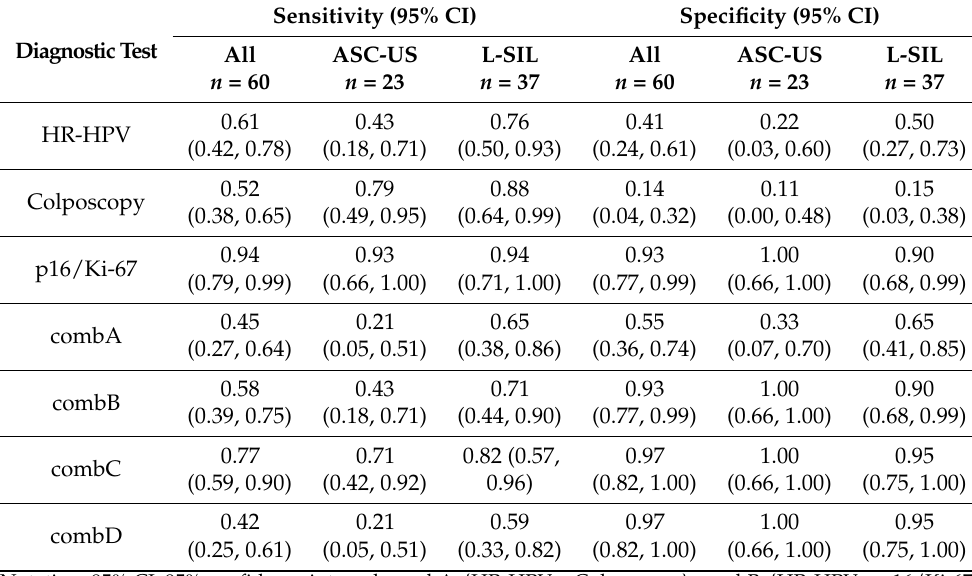
Table 4. Sensitivity and specificity for biopsy-confirmed CIN2+.